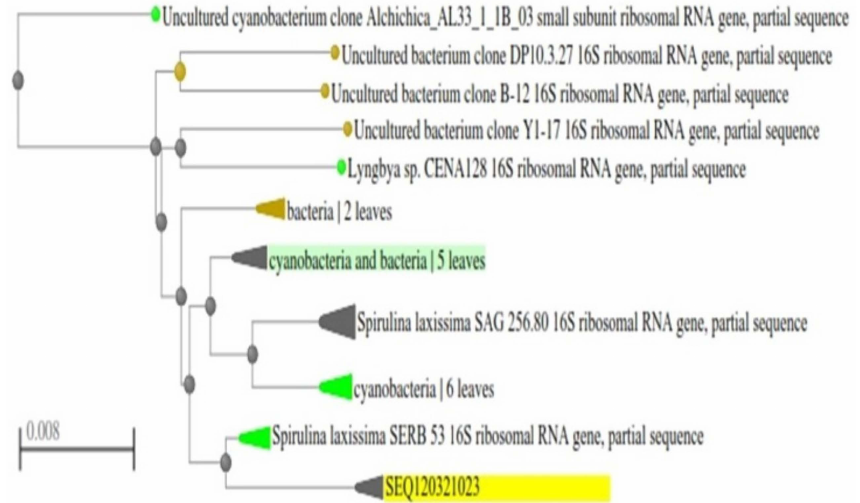
Figure 3. Shows the phylogenetic analysis of the isolated strain. The phylogenetic tree reveals the isolated strains belonging to Spirulina laxissima (NCBI Accession number: MW829712.1). The blast similarity is 99.40% with Spirulina laxissima SERB 53.